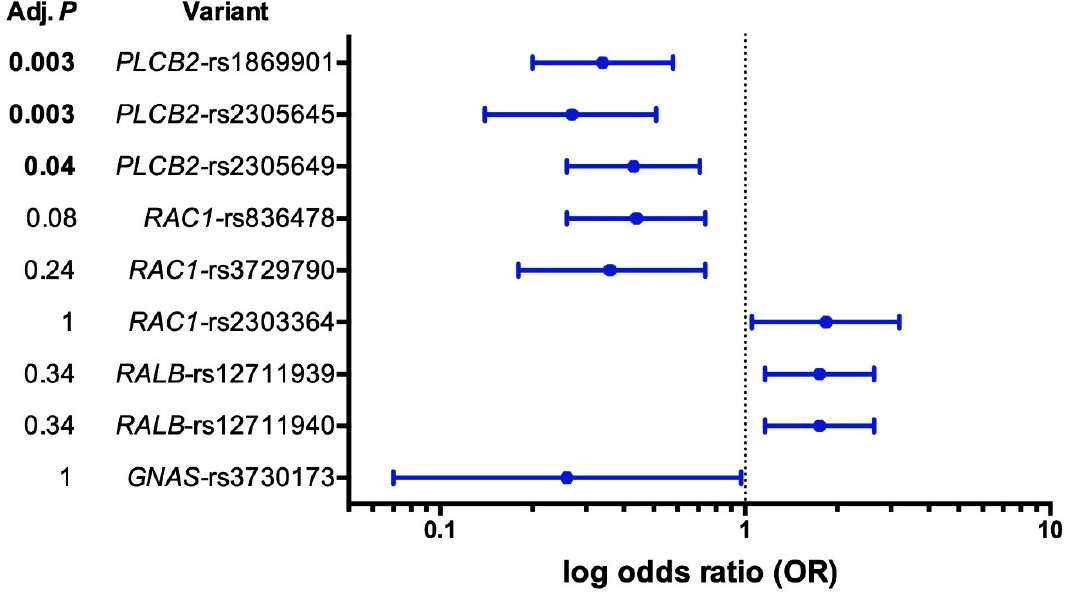
Figure 1. Forest plot for the results of logistic regression. Effect sizes are expressed on a log OR scale. Adj. p , p corrected for multiple testing by Bonferroni adjustment. Adjusted p < 0.05 were considered statistically significant.